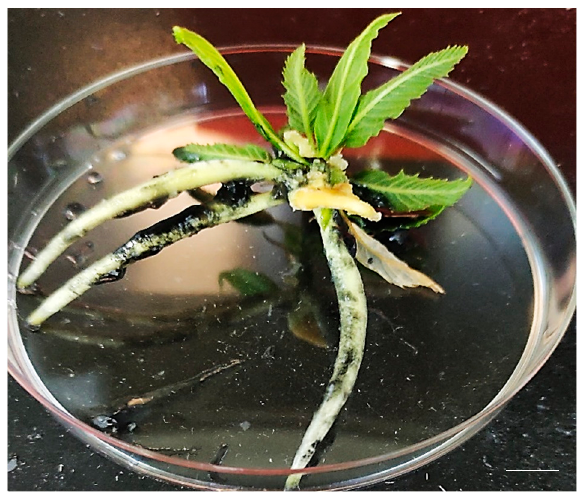
Figure 7. Chestnut rooting following the double-layer method . Bars = 10